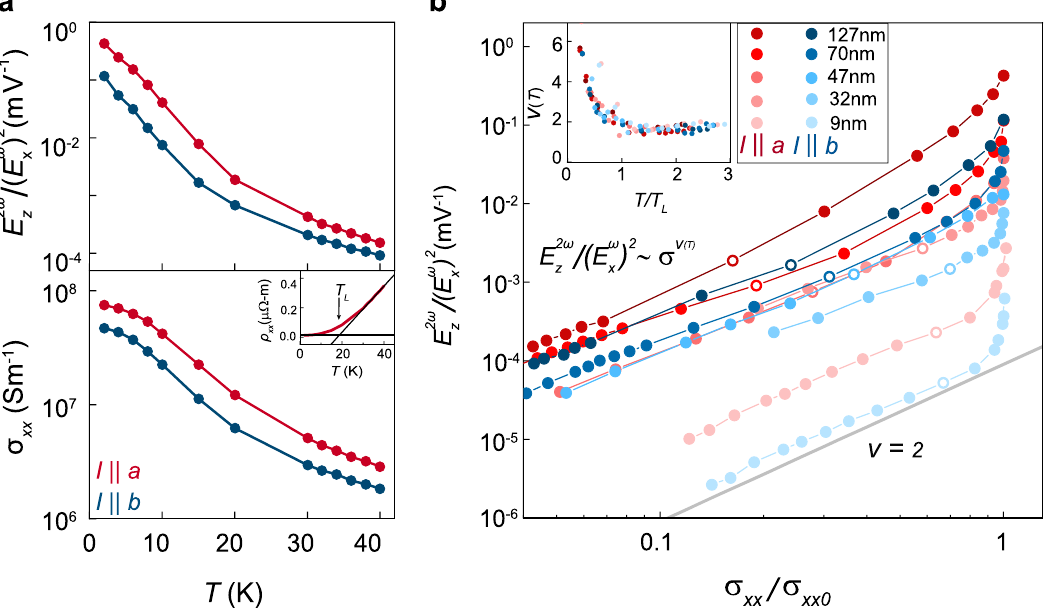
(cid:4) (cid:5) 2 and σ I k a and I k b in 127-nm-thick sample. Inset: Fig. 3 Scaling of the NLAHE with sample conductivity. a Main panel: E 2 ω z = E ω x xx vs. temperature for longitudinal resistivity ρ xx vs. temperature for I k a in same sample. ρ xx crosses over from linear temperature dependence to saturation below T L (cid:3) 18K. (cid:4) (cid:5) 2 vs. σ = σ a and b axes. All traces show scaling close to a power law with exponent of 2 at lower b Main panel: E 2 ω z = E ω x xx xx 0 for all four samples along conductivity (higher temperature) and exhibits an upturn as σ xx approaches σ xx 0 . Open circles mark the data points taken at the temperature closest to T L . Inset: local scaling exponent υ vs. temperature T . υ continually increases above 2 for all traces below T L